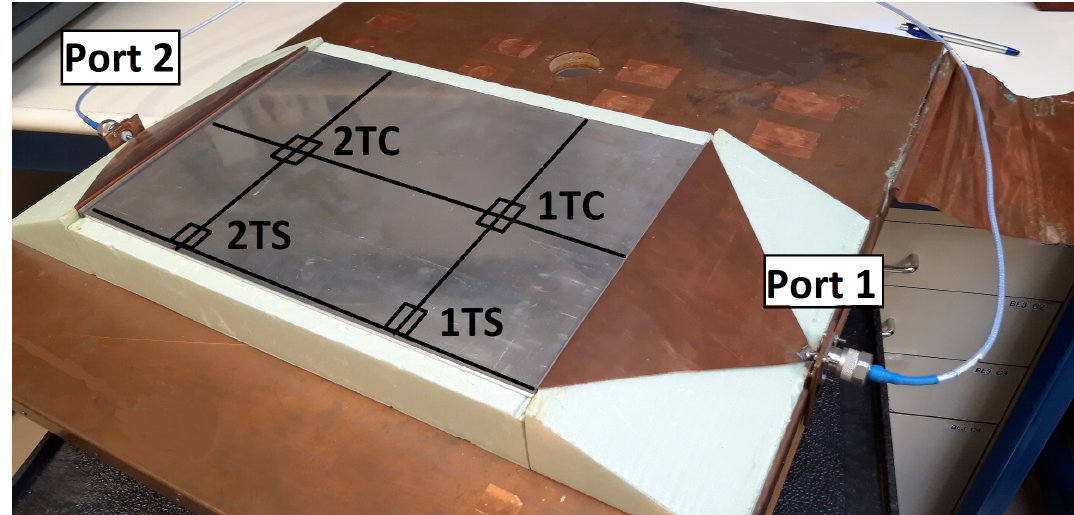
Figure 7. Metallic plate for calibration: imaginary lines in the direction of the current propagation (line “1T” and “2T”) and at the center (C) and end (S) of